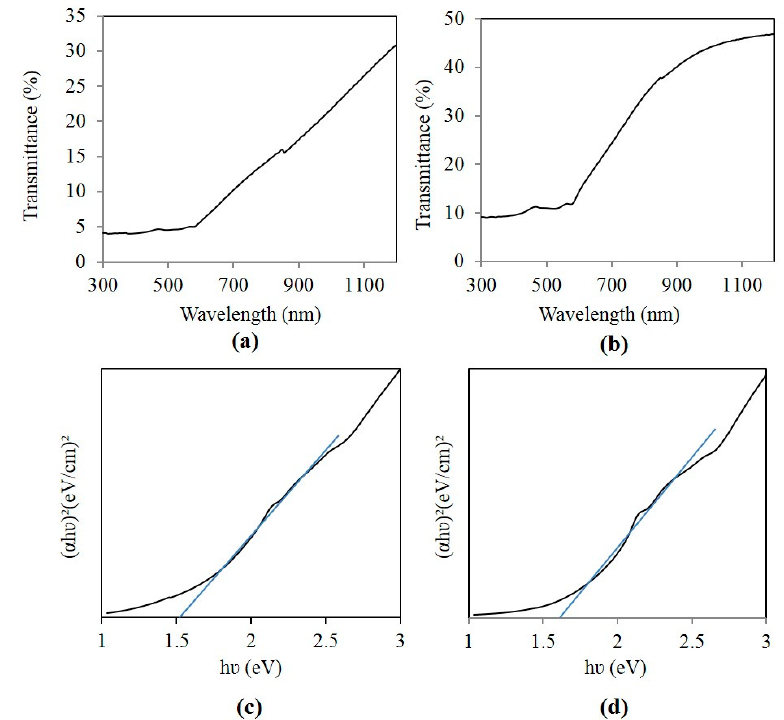
Figure 4. Transmittance spectra of ( a ) irregular-shaped CaMn 2 O 4 particles and ( b ) CaMn 2 O 4 nanowires; Tauc plots of ( c ) irregular-shaped CaMn 2 O 4 particles and ( d ) CaMn 2 O 4 nanowires.